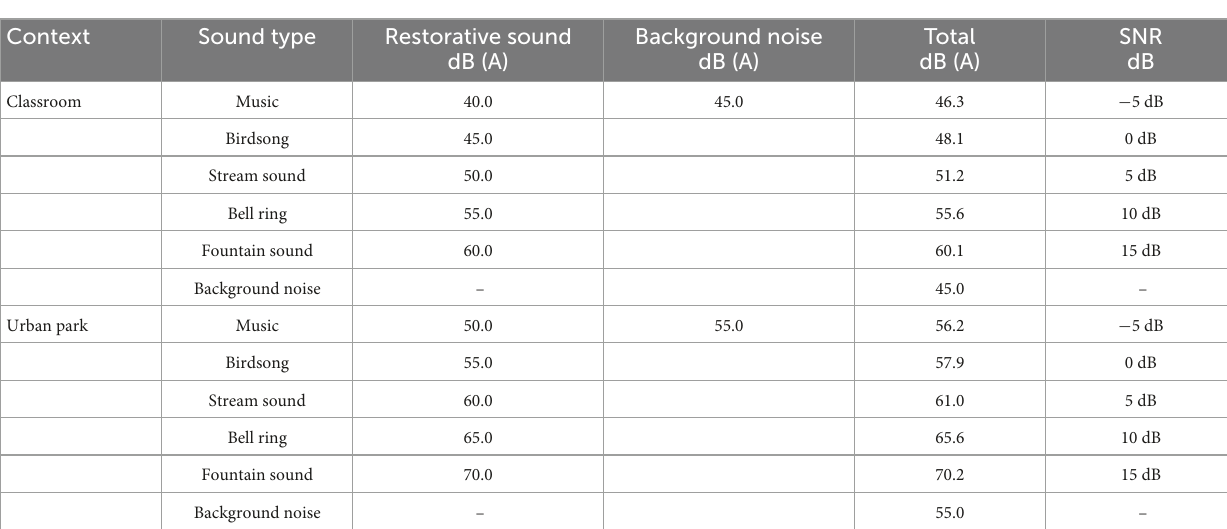
TABLE 2 The acoustic stimuli in the